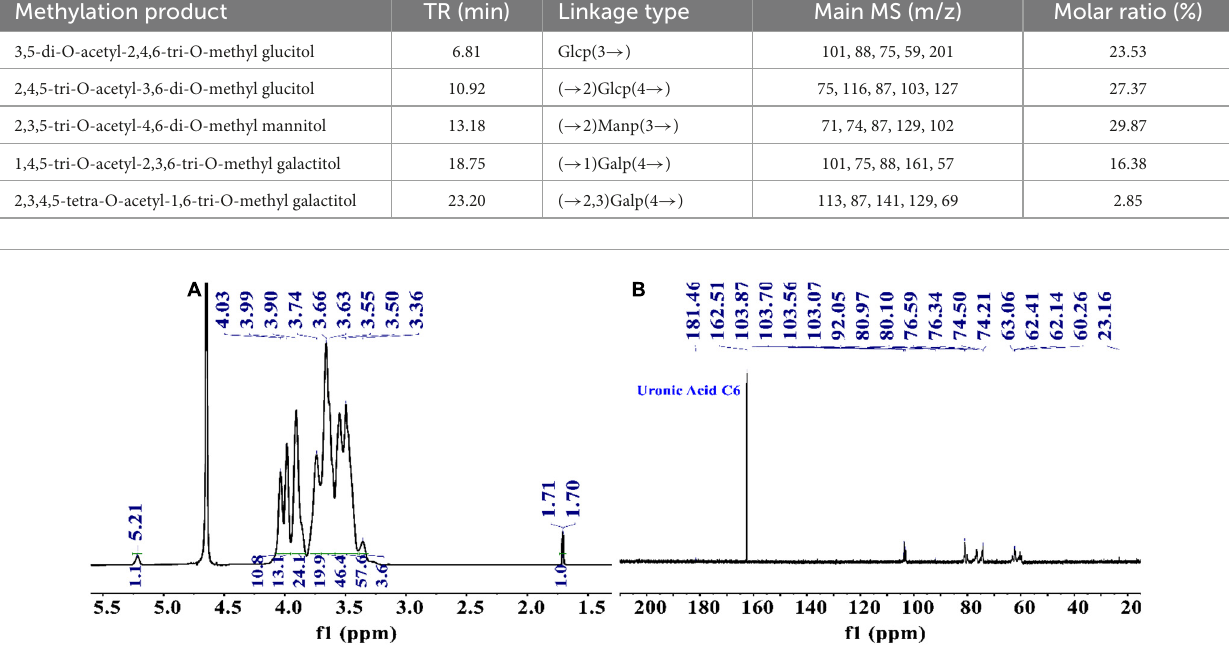
FIGURE3 The structural elucidation of PKP2-1 by NMR analysis. (A) 1 H NMR spectrum; (B) 13 C NMR spectrum.